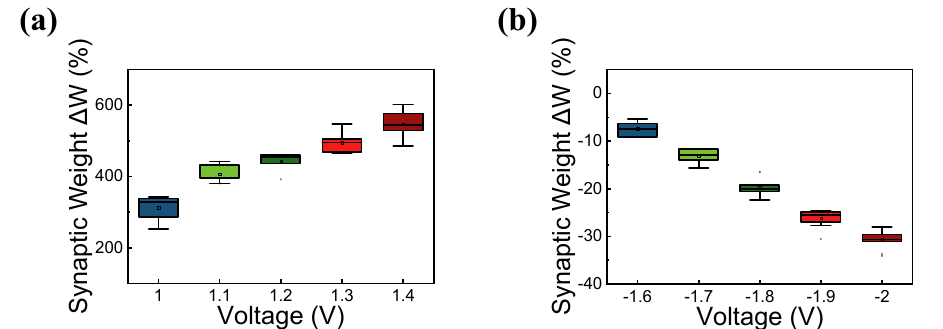
Figure 6. ( a ) Pulse schemes of pre-spike (black line) and post-spike (red line). ( b ) Pre-spike occurs before post-spike by Δ t, causing the overlapped pulse for potentiation. ( c ) Pulse schemes of pre- spike (black line) and post-spike (red line). ( d ) Pre-spike occurs after post-spike by Δ t, causing the overlapped pulse for depression. ( e ) Synaptic weight change as a function of spike time for STDP emulation.